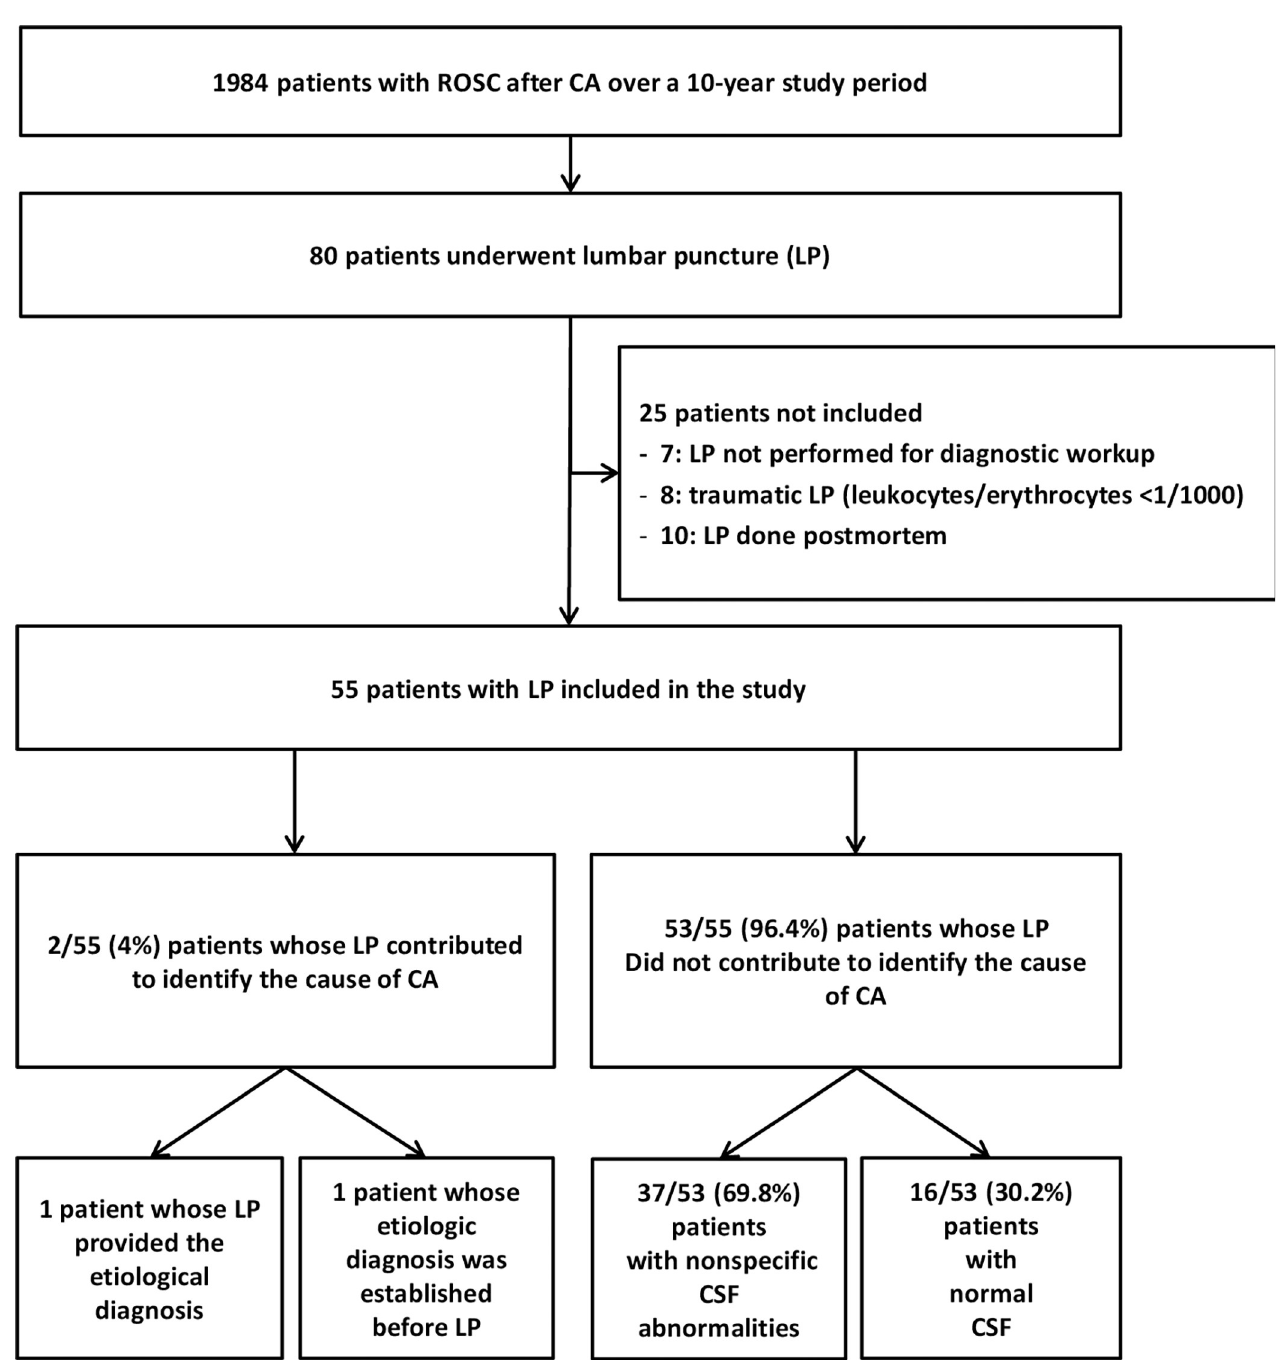
Fig 1. Patient flow diagram. ROSC: Return of spontaneous circulation; CA: Cardiac arrest; CT: Computed tomography. Among the 53 patients whose CSF analysis did not help to identify the cause of CA, 37 (69.8%) had CSF abnormalities (Table 2). CSF protein elevation was found in 34 (94.4%)